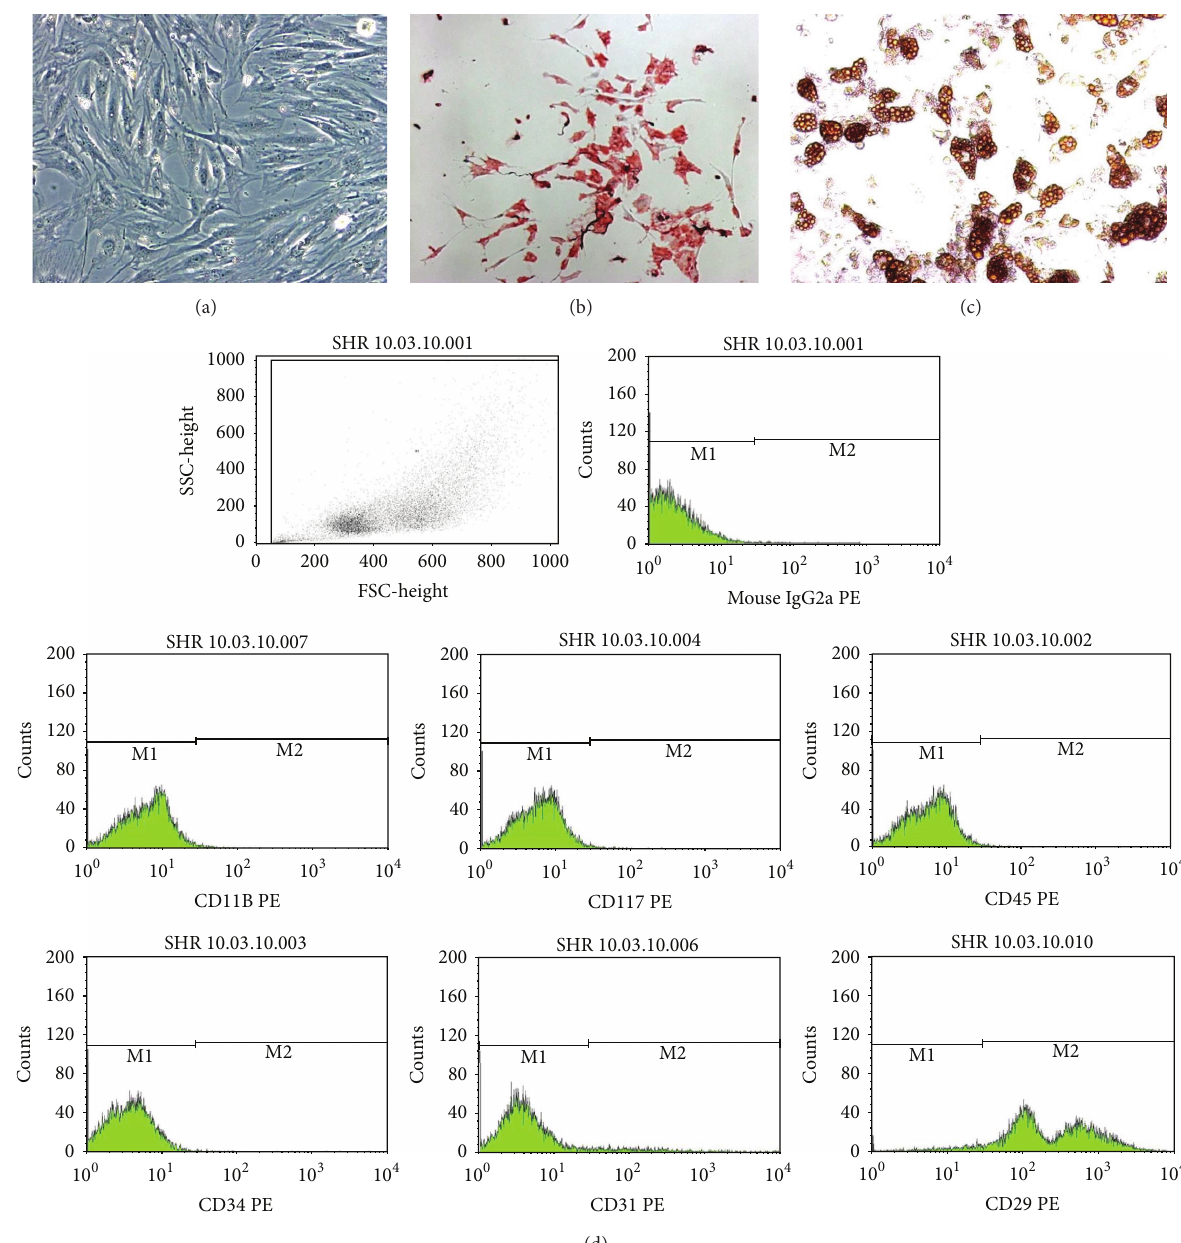
Figure 1: Phase-contrast micrographs of MSCs in culture (Panel (a)), showing the typical fibroblastoid morphology. Differentiation of MSCs, which were cultured in osteogenic and adipogenic medium as previously described. Calcium deposited in the extracellular matrix is stained red by Alizarin Red (Panel (b)). Lipid vacuoles are stained orange with Oil Red O (Panel (c)). Magnifications, × 100 (Panels (a)–(c)). (Panel (d)) ImmunophenotypicprofileofMSCsculturedinconventionalmedium.Flowcytometryexpressionofselectedmolecules(CD11b,CD117(cKit), CD45, CD34, CD31 and CD29) by MSC population.